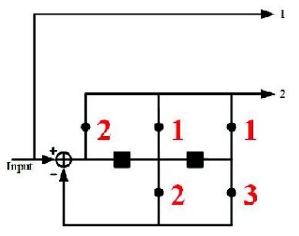
η η η = 4.8. = 4.8. = 4.8.